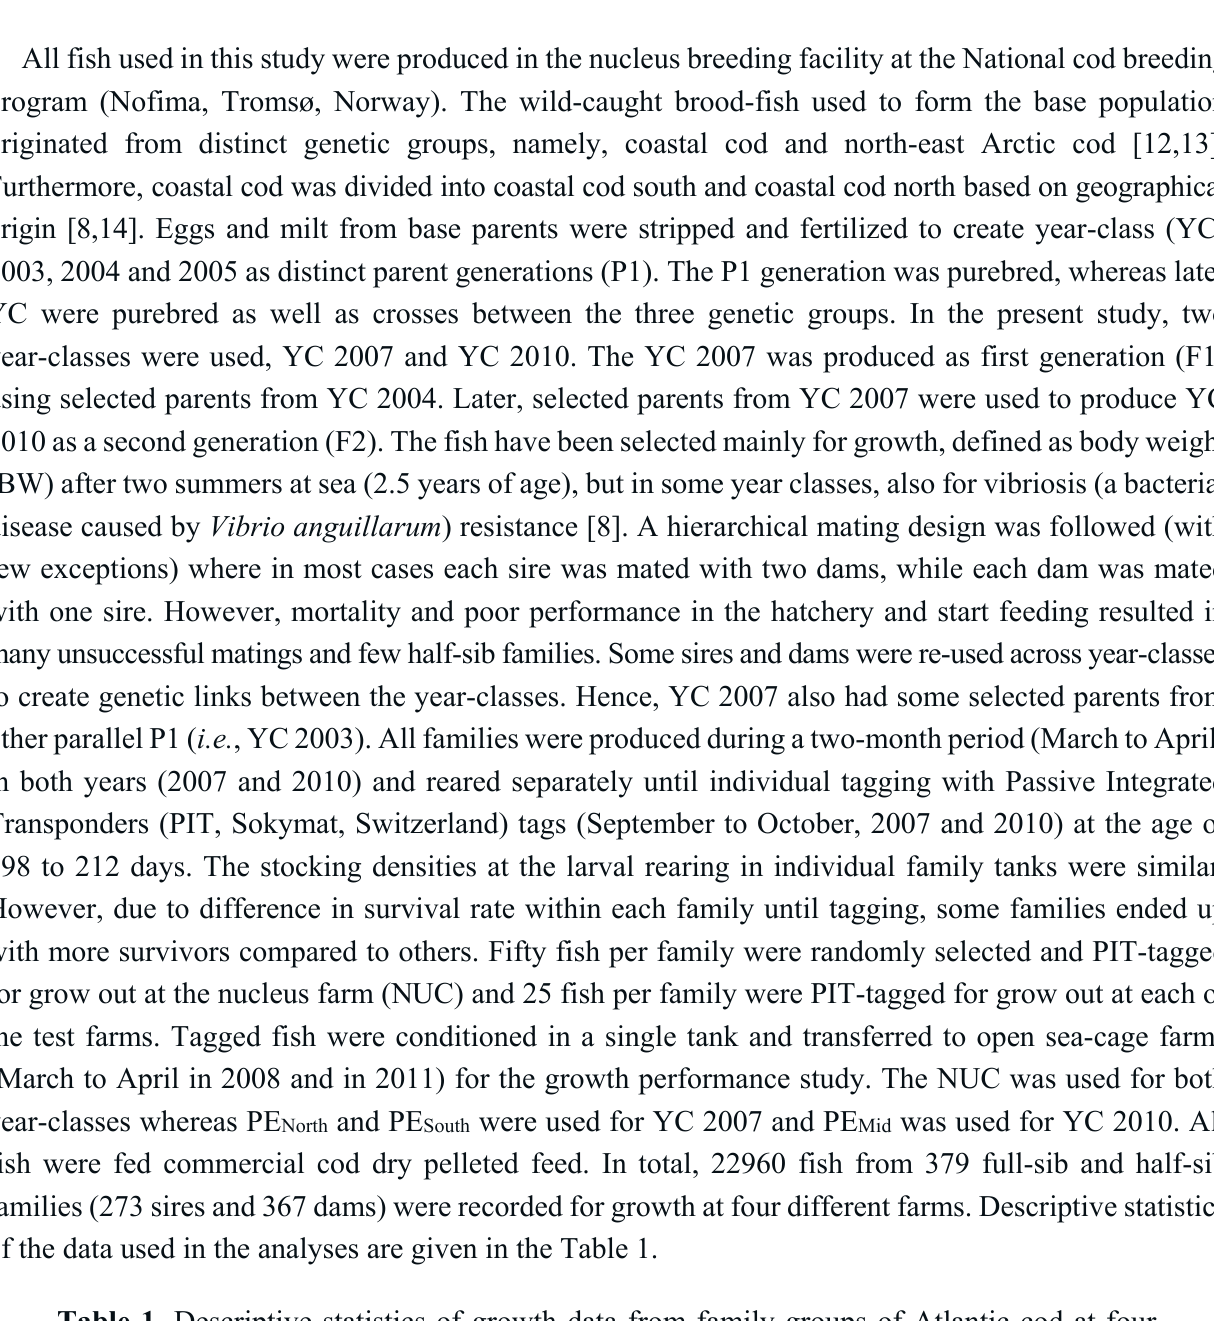
Table 1. Descriptive statistics of growth data from family groups of Atlantic cod at four farms in